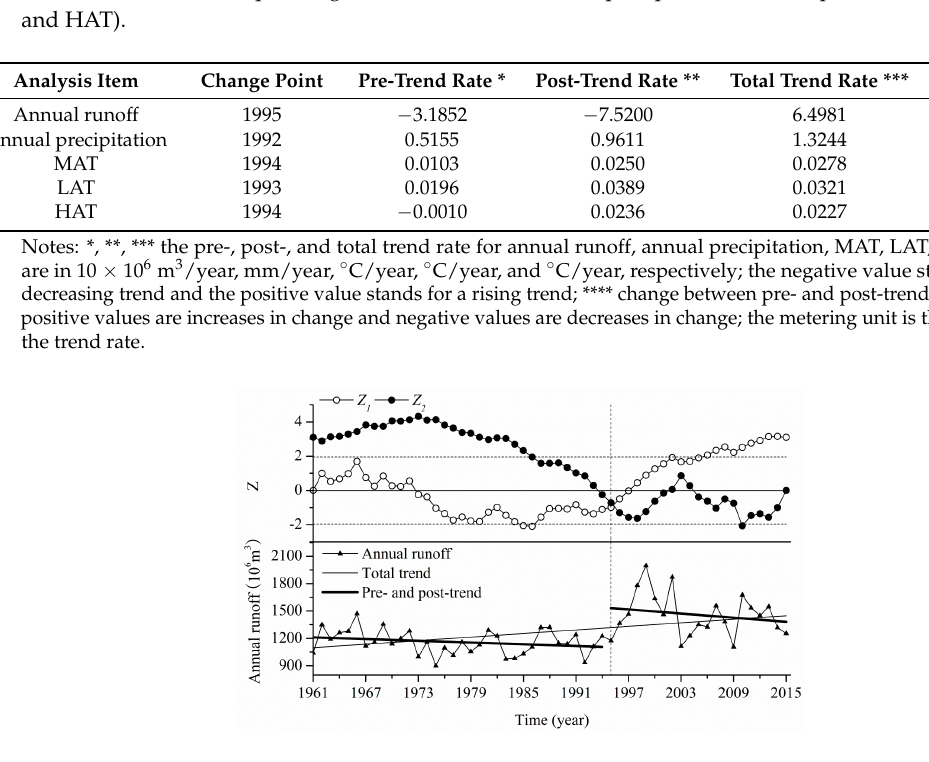
Figure 2. Nonparametric Mann-Kendall (MK) test and liner regression analysis of annual runoff.